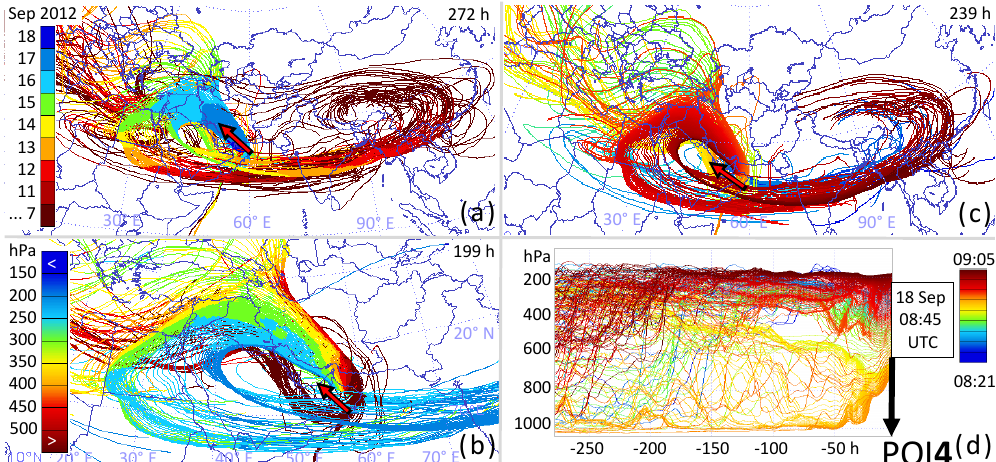
Figure A3. As Fig. 3, but for POI4. This flight segment covers the dive from the UT into the mid-troposphere. The interval for POI4 is chosen such that anticyclonic motion is much slower compared to the ASMA circulation above: air from the highest altitudes of POI4 does not quite circle the ASMA within 300h, while air from POI3/5 needs about 200 and 280h (Figs. 3, A4). The source regions contributing to POI4 primarily depend on the actual flight altitude; i.e. the sequence of air masses encountered during descent is mirrored during the following ascent.